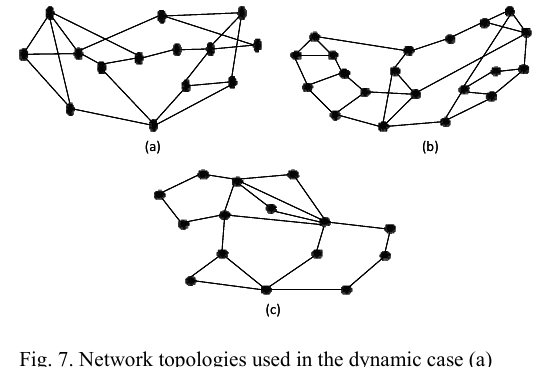
Fig. 7. Network topologies used in the dynamic case (a) NSFNET, 14 nodes and 22 links (b)ARPANET, 20 nodes and 31 links (c) Interconnected ring, 15 nodes and 21 links.